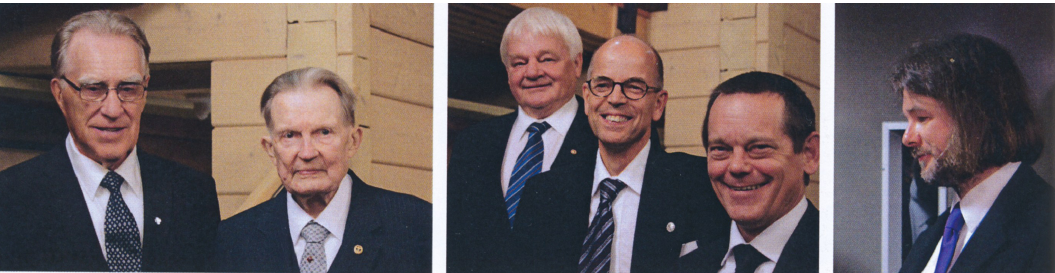
Figure 13. At the festivities of the 100th anniversary of SGO in 2013, where five directors of the observatory (past and present) met. From left to right: Jorma Kangas and Eero Kataya, Tauno Turunen, Esa Turunen, and, on the far right, Thomas Ulich, followed by Craig Heinselman, who was the director of EISCAT at that time (photo supplied by SGO).